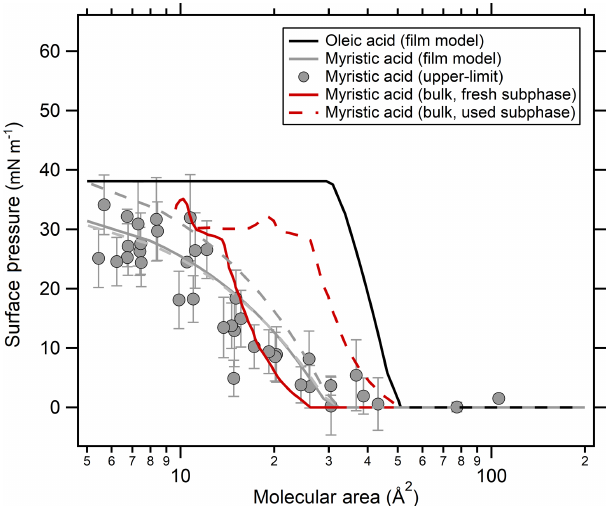
Figure 3. Upper-limit and the film model π estimates for NaCl par- ticles coated with myristic acid as a function of molecular area. Un- certainties in surface pressure are estimated from precision in RH. The black line is the film model estimate for pure oleic acid and the red lines are macroscopic measurements of surface pressure adapted from Albrecht et al.